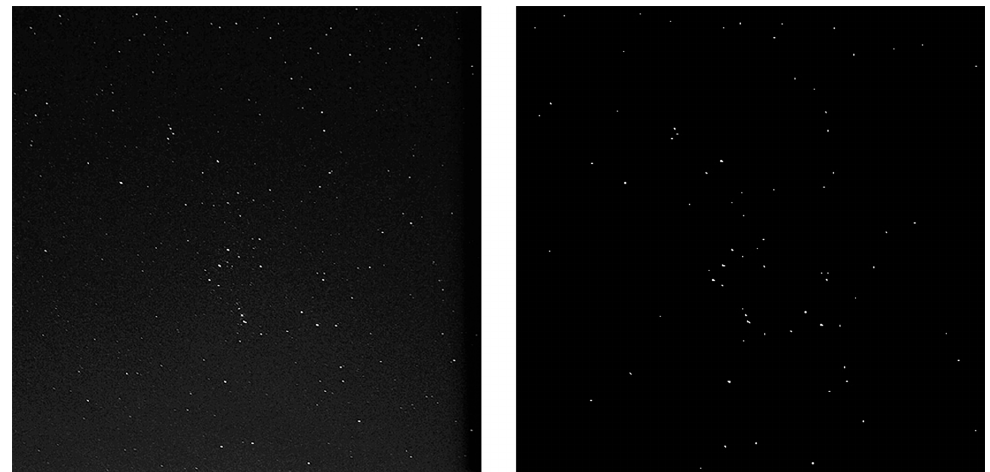
Figure 3. Dataset samples: real night sky image (on the left ) and relative mask (on the right ). It must be pointed out that the dataset does not contain only point-like stars but also even images where they appear as streaks due to the angular speed of the sensor.